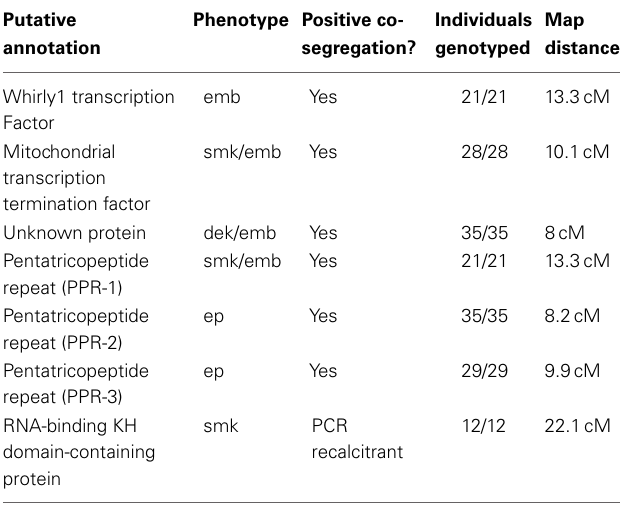
Table 3 | Genetic analyses of progeny.